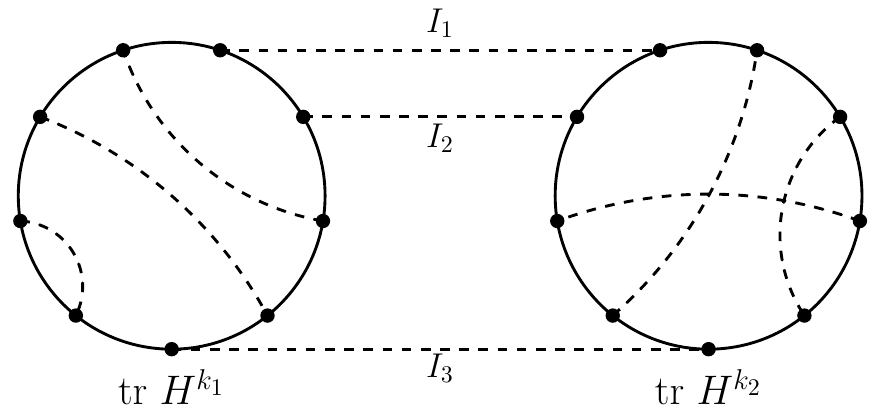
Figure 17 . An example of a diagram contributing to the odd double trace with k 1 = k 2 = 9 . Here we show the full multi-trace chord diagram, including the internal chords within each trace.